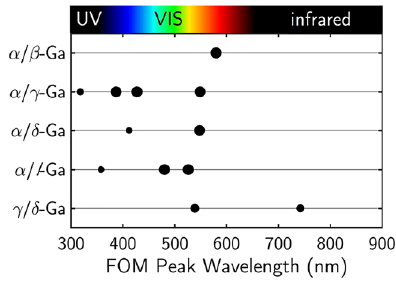
Figure 6: Spectral position of the figure-of-merit (FOM) = Δ n / Δ k peaks appearing for different Ga phase transformations. The size of the dot is related to the value of the FOM at the